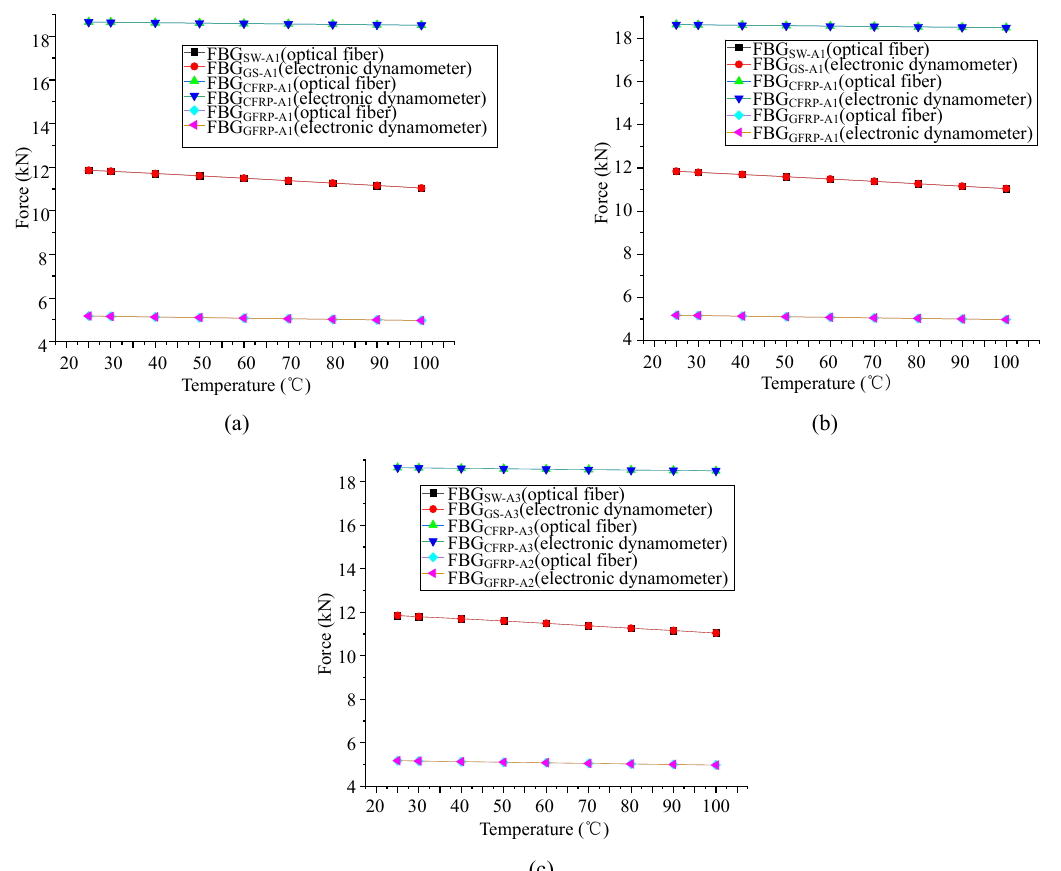
Fig. 11 Comparison of stress monitoring after the FBG temperature compensation of different substrate materials: (a) 1 532 nm, (b) 1 540 nm, and (c) 1 548